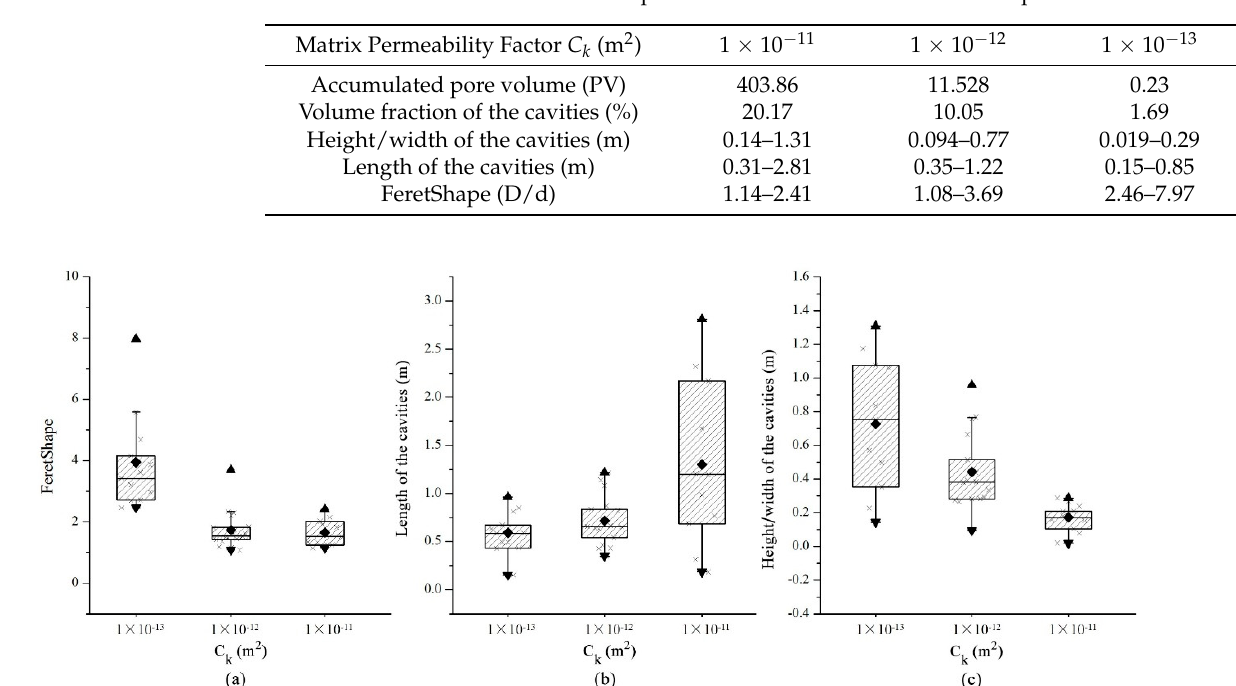
Table 5. Statistics of the characteristic parameters for different cross fracture permeabilities.